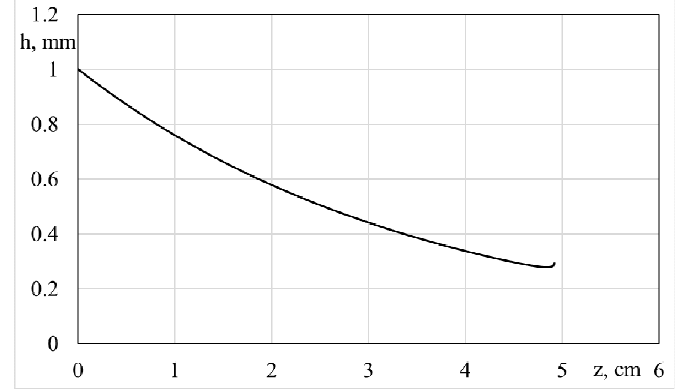
Fig. 3. The depth of the water along the channel. Initial velocity 2